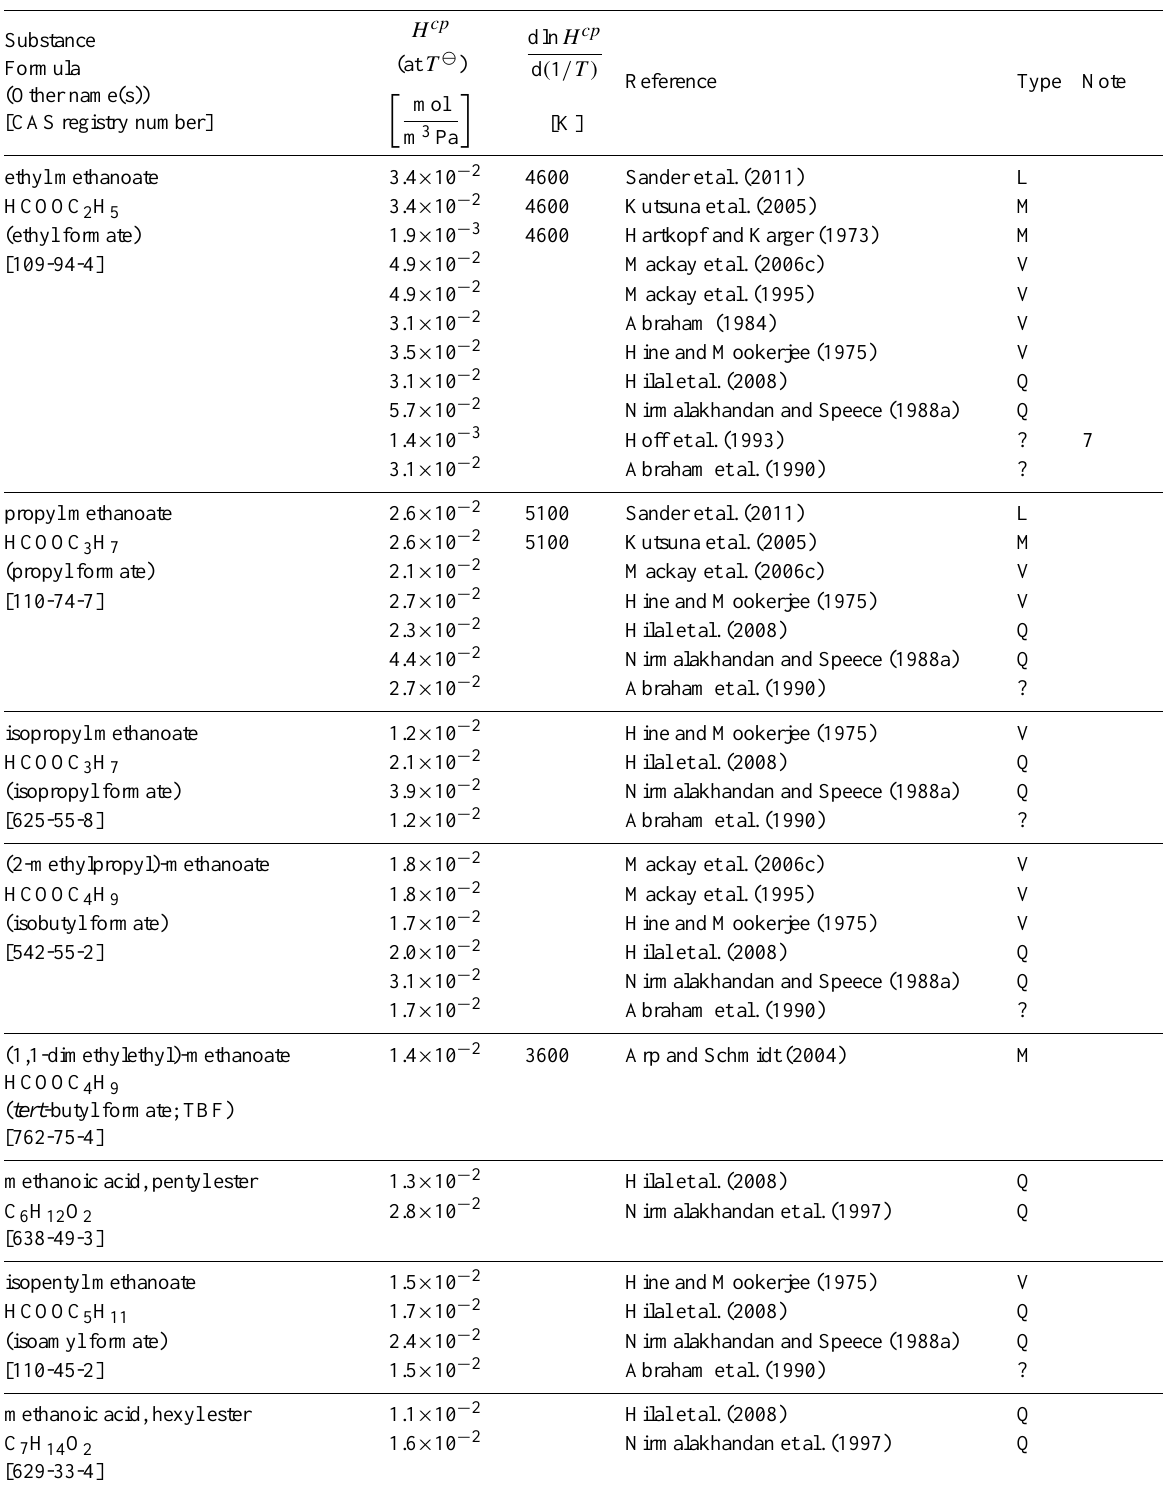
Table 6: Henry’s law constants for water as solvent